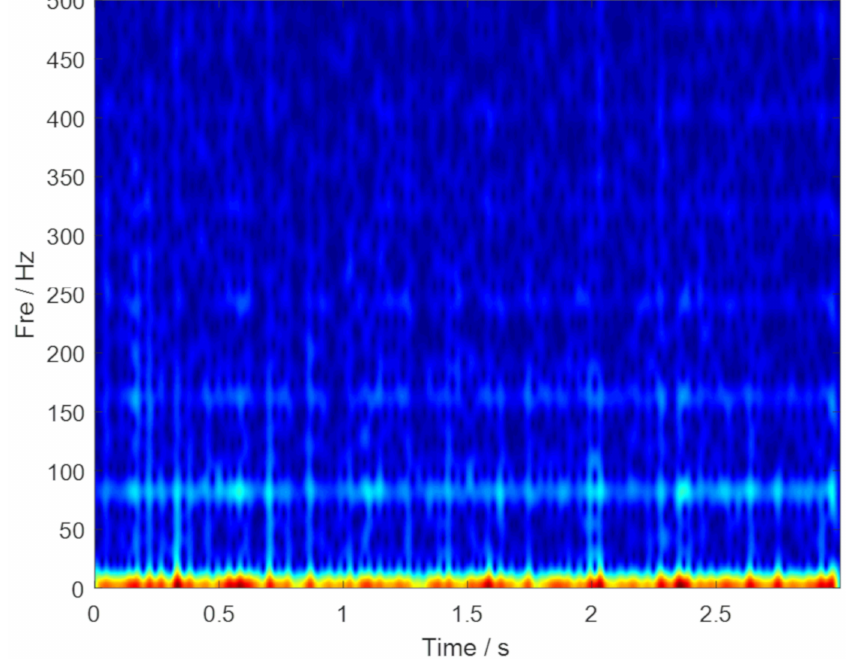
Figure 10. TF representations of the envelope